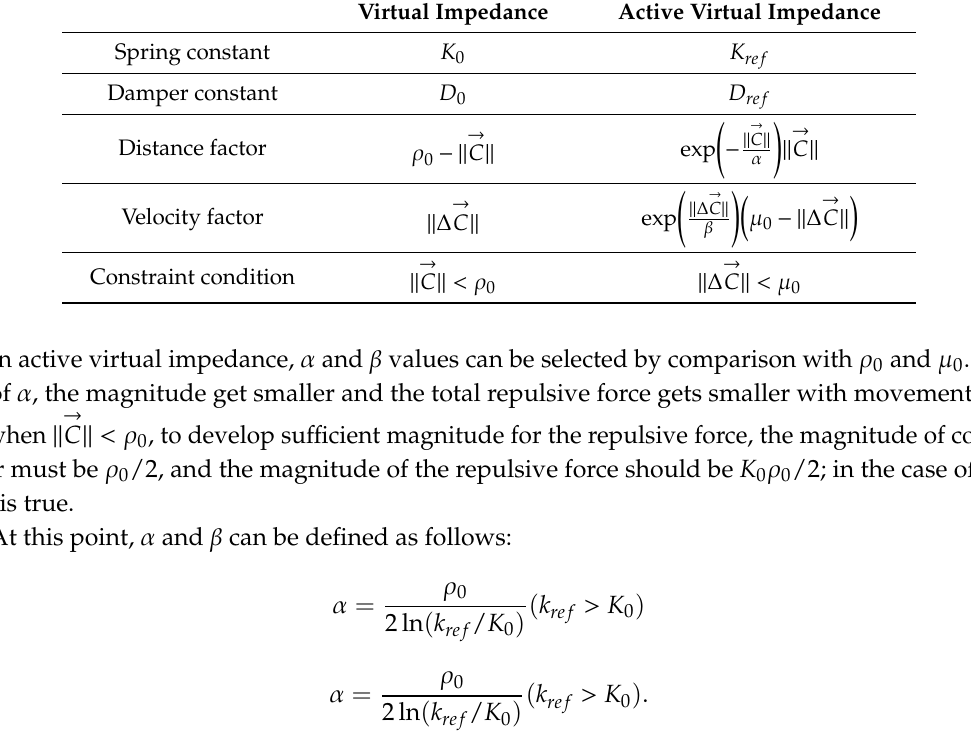
Table 4. The comparison of virtual impedance algorithms. Virtual Impedance Active Virtual